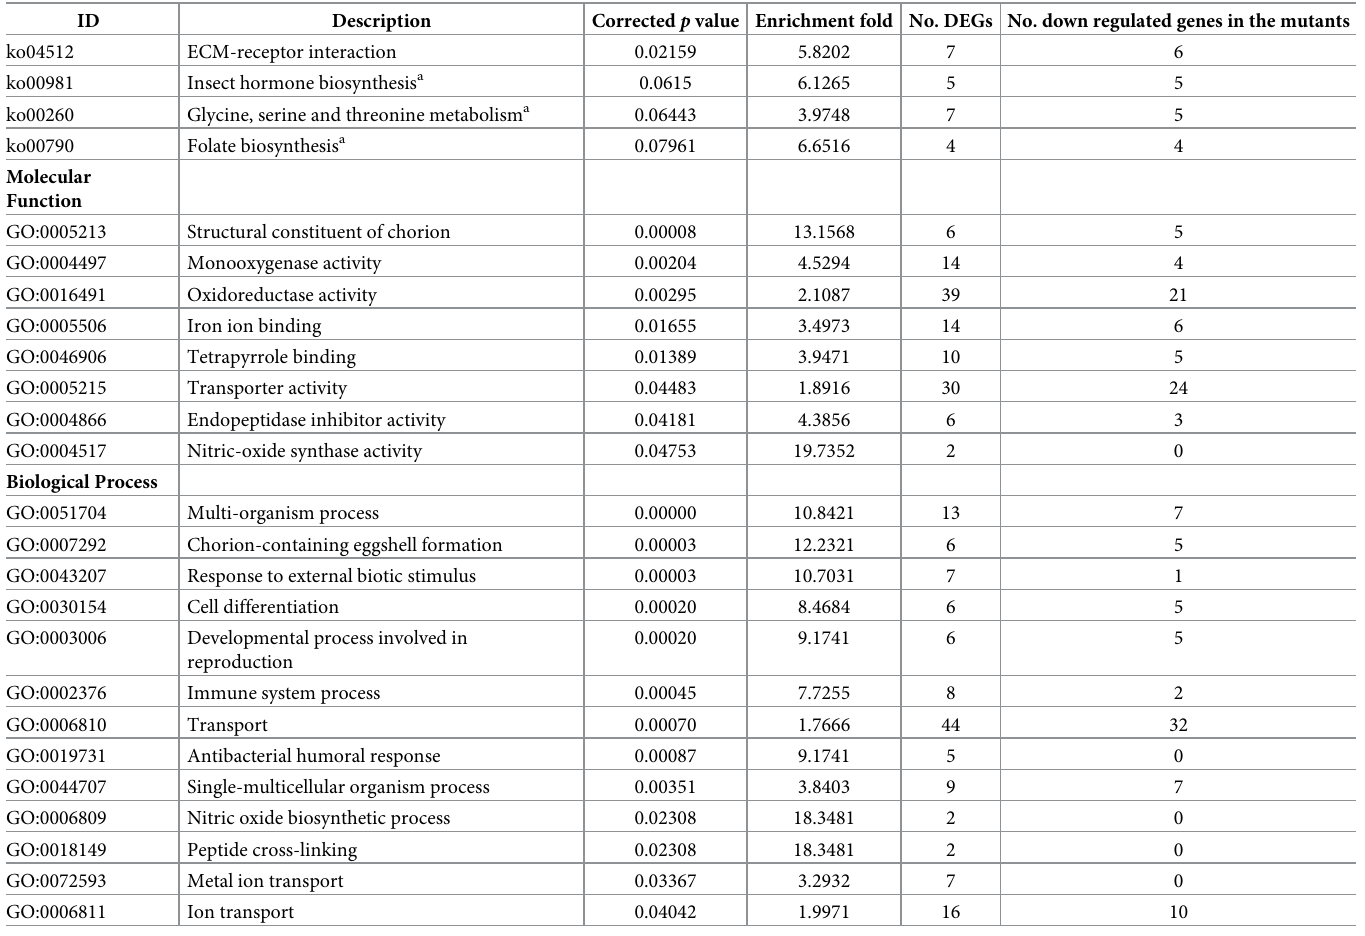
Table 3. Functional enrichment of differential expressed genes between the loss-of-function SP1 mutants and the wild-type domestic